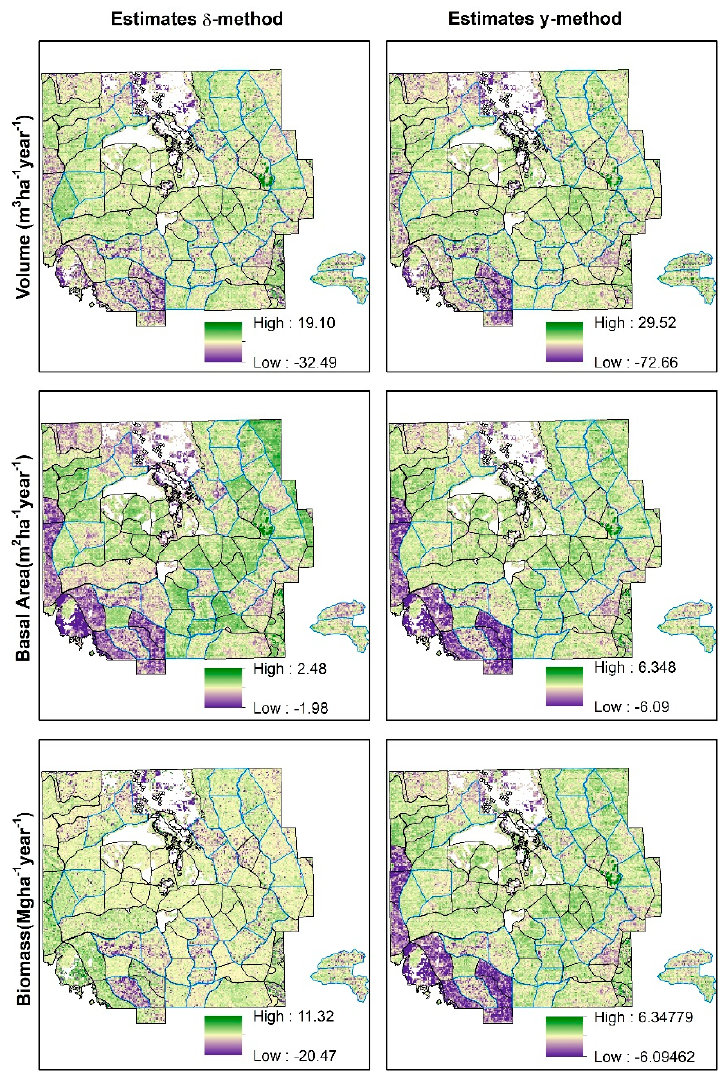
Figure A1. Maps of change in V, BA and B and corresponding pixel-level RMSE maps for the δ -modeling method.